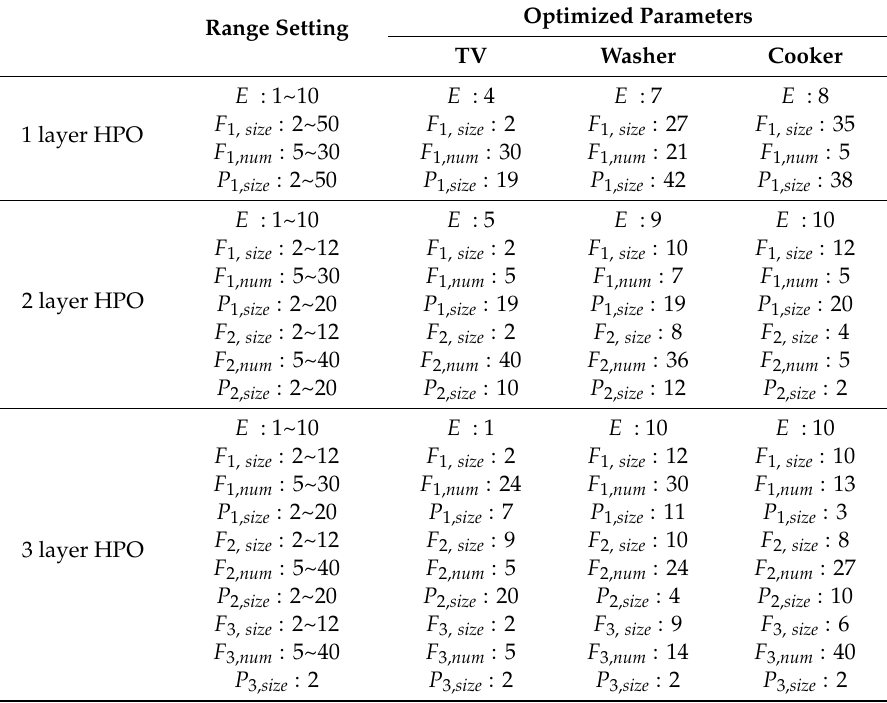
Figure 9. Architecture of subtask gated networks (SGN). ‘FC’ represents a fully connected layer.